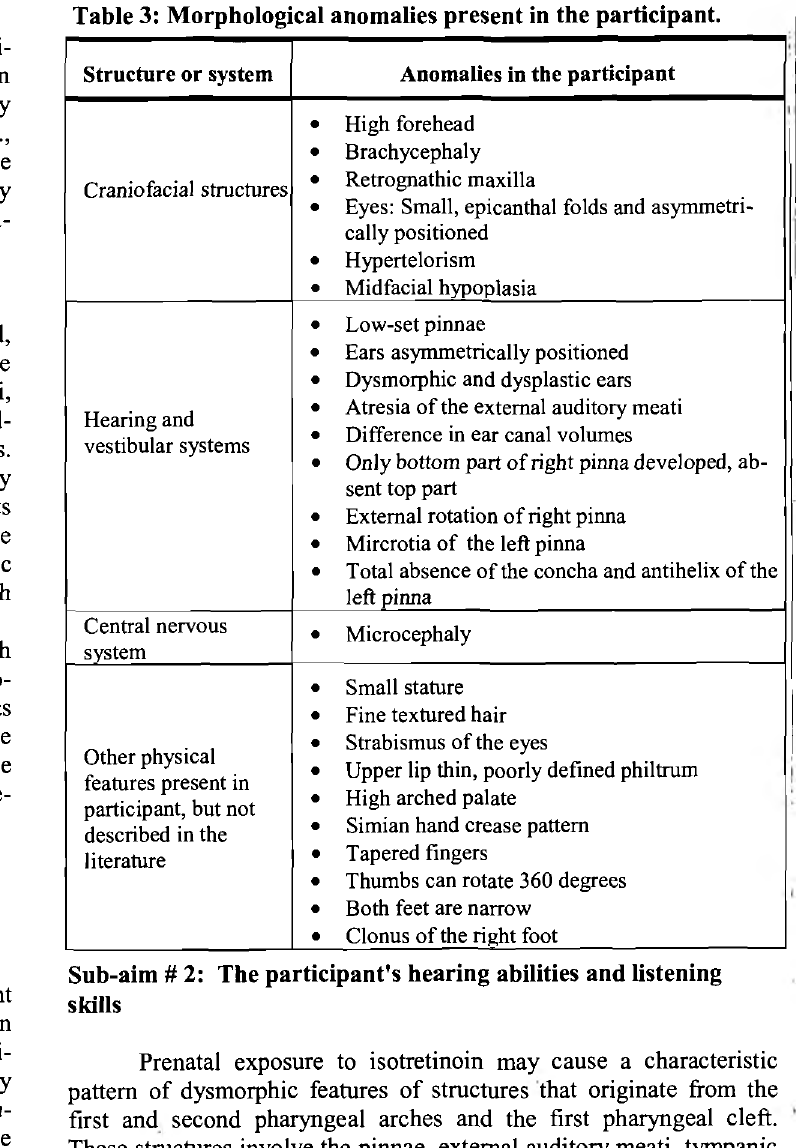
Table 3: Morphological anomalies present in the